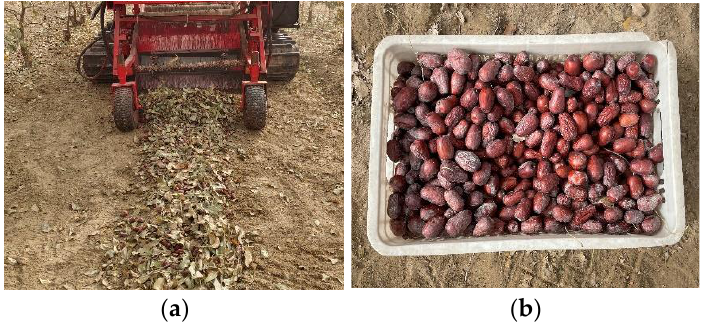
Figure 15. ( a ) Field test of a floor-standing jujube pickup device . ( b ) Jujubes picked up by devices .